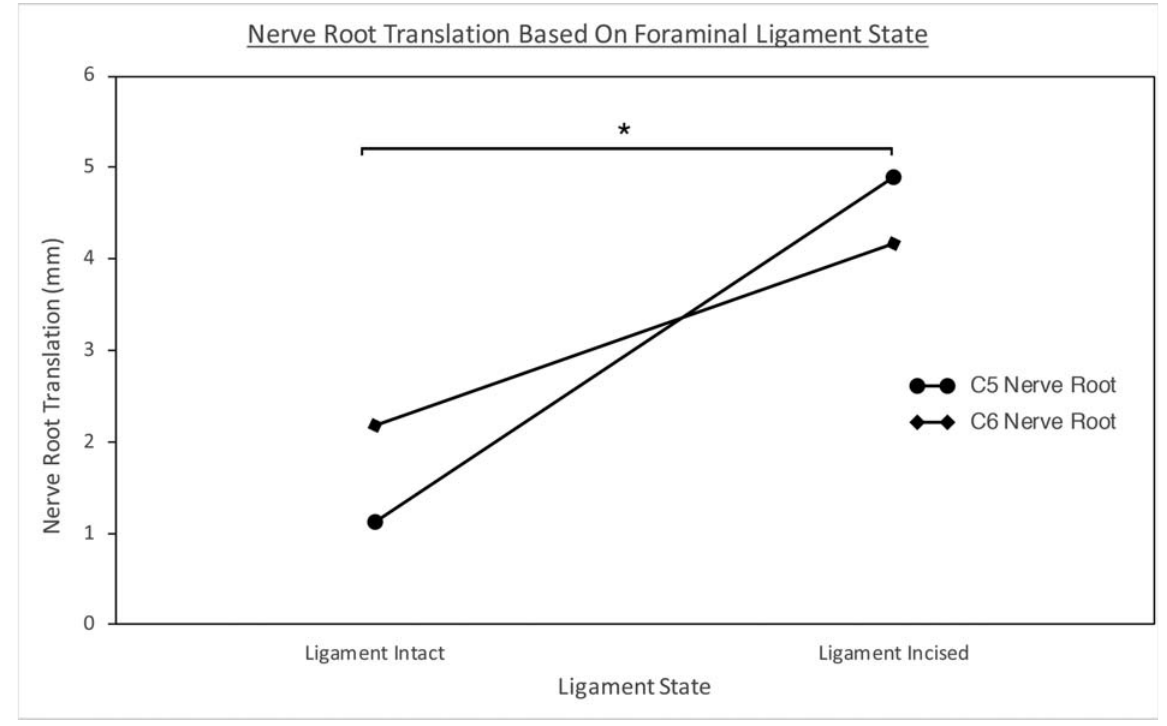
Fig. 2 The effect of foraminal ligament cutting on nerve root translation. There was a signi fi cant difference between nerve root translation pre- and postligament incision (denoted by (cid:2) ) for both C5 and C6 nerve